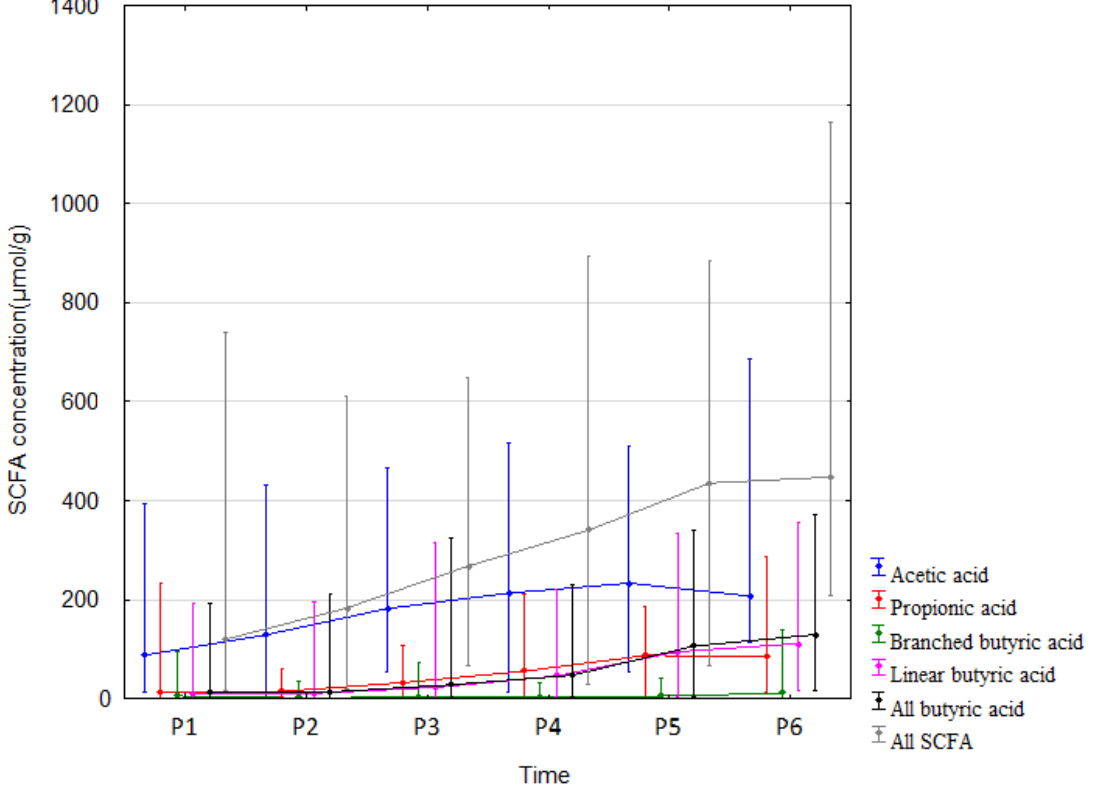
Figure 2. SCFA concentrations (median) over time (P1–P6 from left to right). Legend: Error bars represent range. From Wilcoxon paired test regarding time. Acetic acid: p < 0.05 P1 vs. P2, P4, P5, P6; p < 0.05 P2 vs. P3, P4, P5, P6. Propionic acid: p < 0.05 P1 vs. P2, P4, P5, P6; p < 0.05 P2 vs. P4, P5,